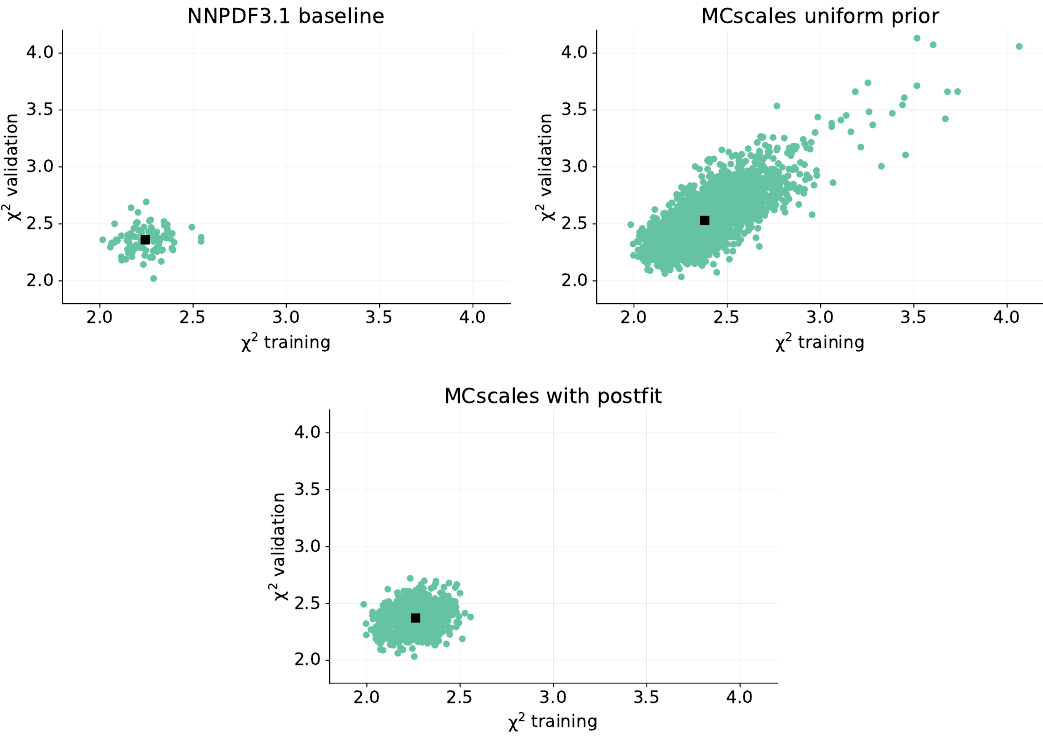
Figure 1 . The values of the training and validation χ 2 per replica for the NNPDF3.1 baseline (top left), the MCscales uniform prior (top right) and the MCscales with postfit set (bottom). The result for each replica is plotted in green, with the mean plotted with a black square.